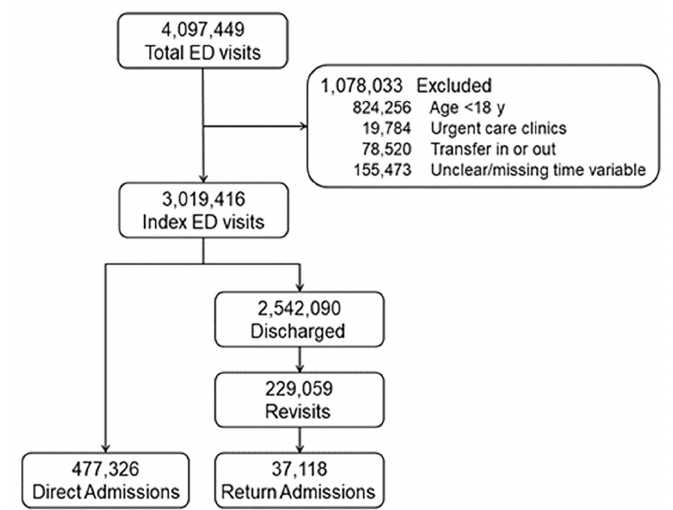
Figure. Flow diagram of the patient selection